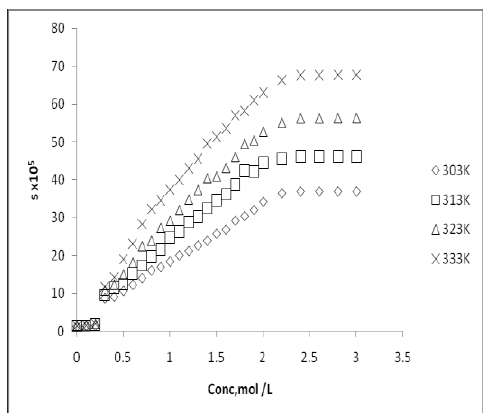
Figure 7. Effect of sodium thiocyante concentration ( C ) on solubility of m-